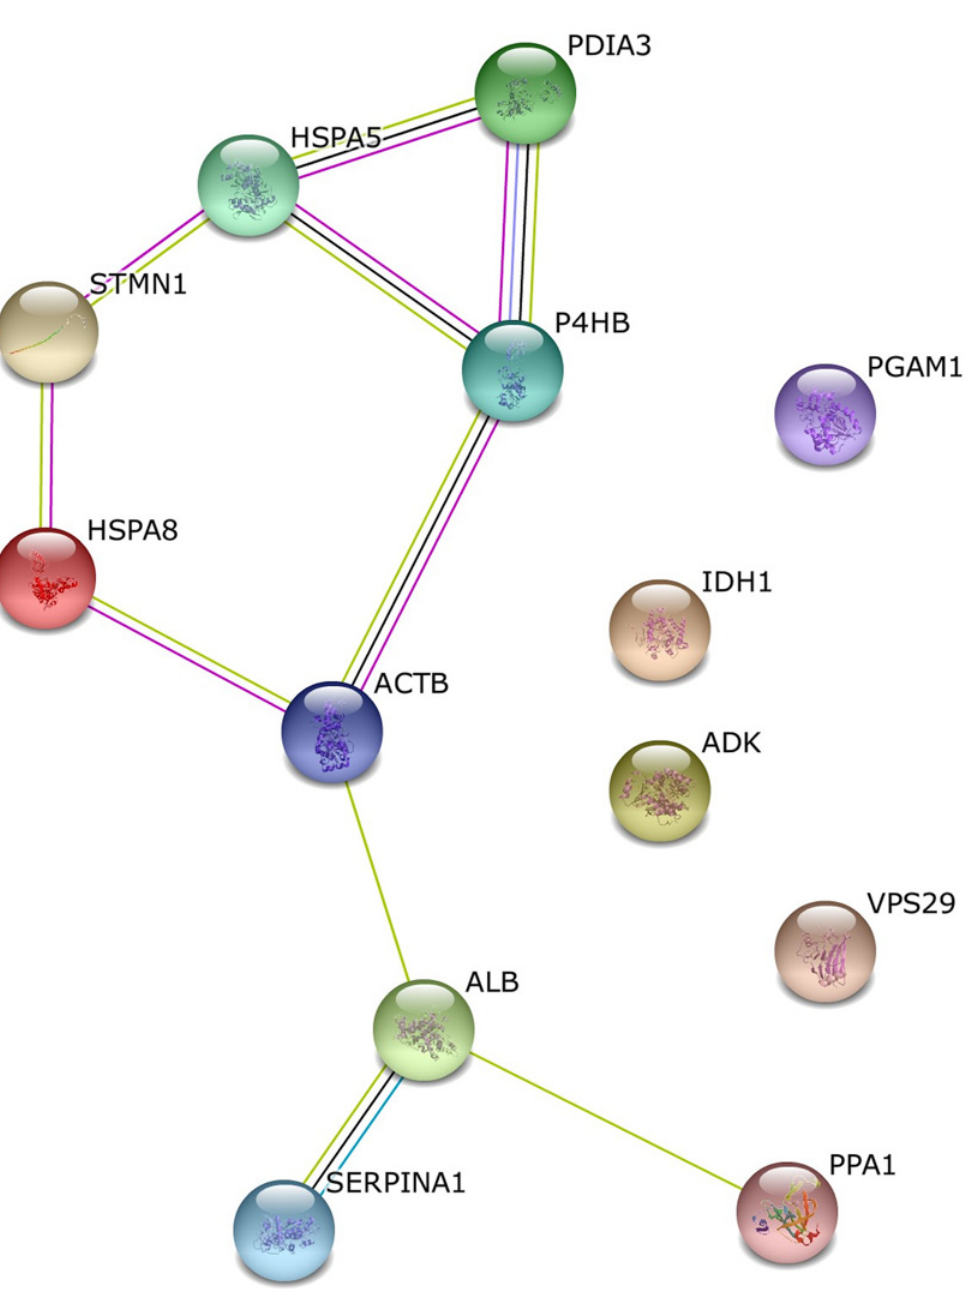
Fig 5. Protein interaction network of altered proteins at Day 24. In the network generated by STRING v.9.1, each node represents a protein and each edge represents an interaction, coloured by evidence type (see STRING website for colour legend).